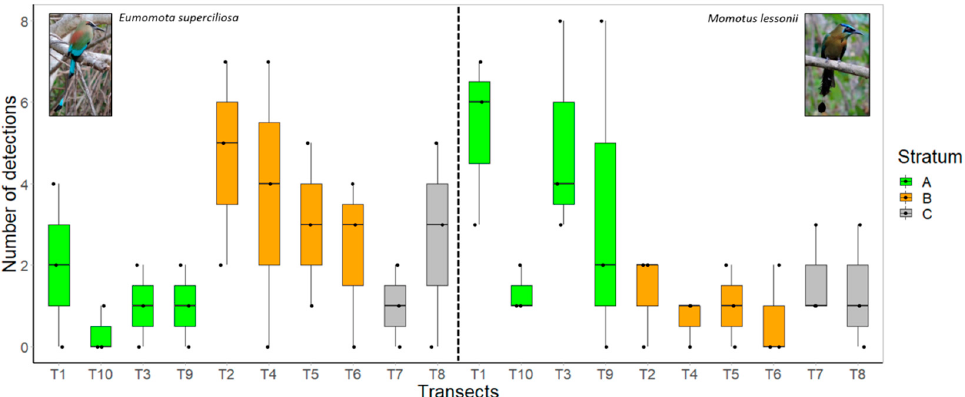
Figure 4. Boxplots of number of detections for the two species ( E. superciliosa on the left, M. lessonii on the right) obtained through the Distance Sampling method between February and March 2019. Stratum A (in green): primary transitional moist forest; stratum B (in orange): secondary transitional dry forest. Altered transects (T7 and 78) are reported (stratum C; in grey) although not included in the habitat analysis. For each transect ( X -axis), values of the three replicates are shown (black dots). ANOVA revealed significant differences in the relative abundance for each species in the two habitats and in each habitat between the two species ( p < 0.05). The mean KAIs of E. superciliosa were 1.88 and 6.63 in the transitional moist forest and transitional dry forest, respectively, while the mean KAIs of M. lessonii were 6.32 in the transitional moist forest and 1.79 in the transitional dry forest (Table